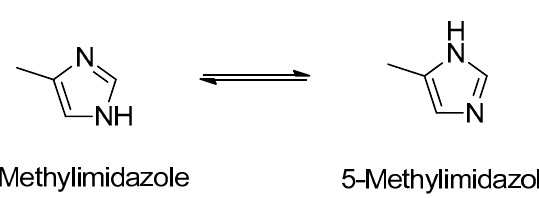
Figure 1. Tautomeric equilibrium of 4(5)-methylimidazole.